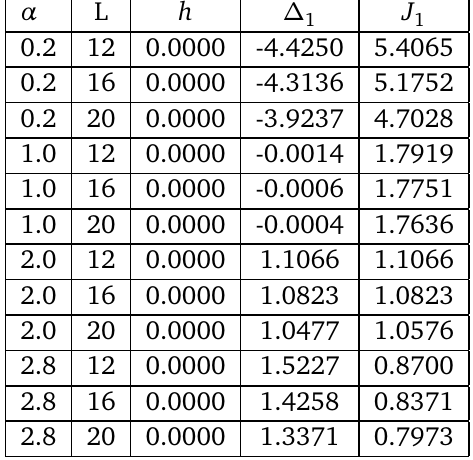
Table 1: Converged couplings using the NN ( 2 ) basis for different α and L . Here we present the results for an unconstrained optimization in order to benchmark the algorithm. The data indicate the symmetry is always preserved, while the relative ration of the couplings are consistent with the exact cases: α = 1 with the X X -chain and α = 2 with the Haldane-Shastry